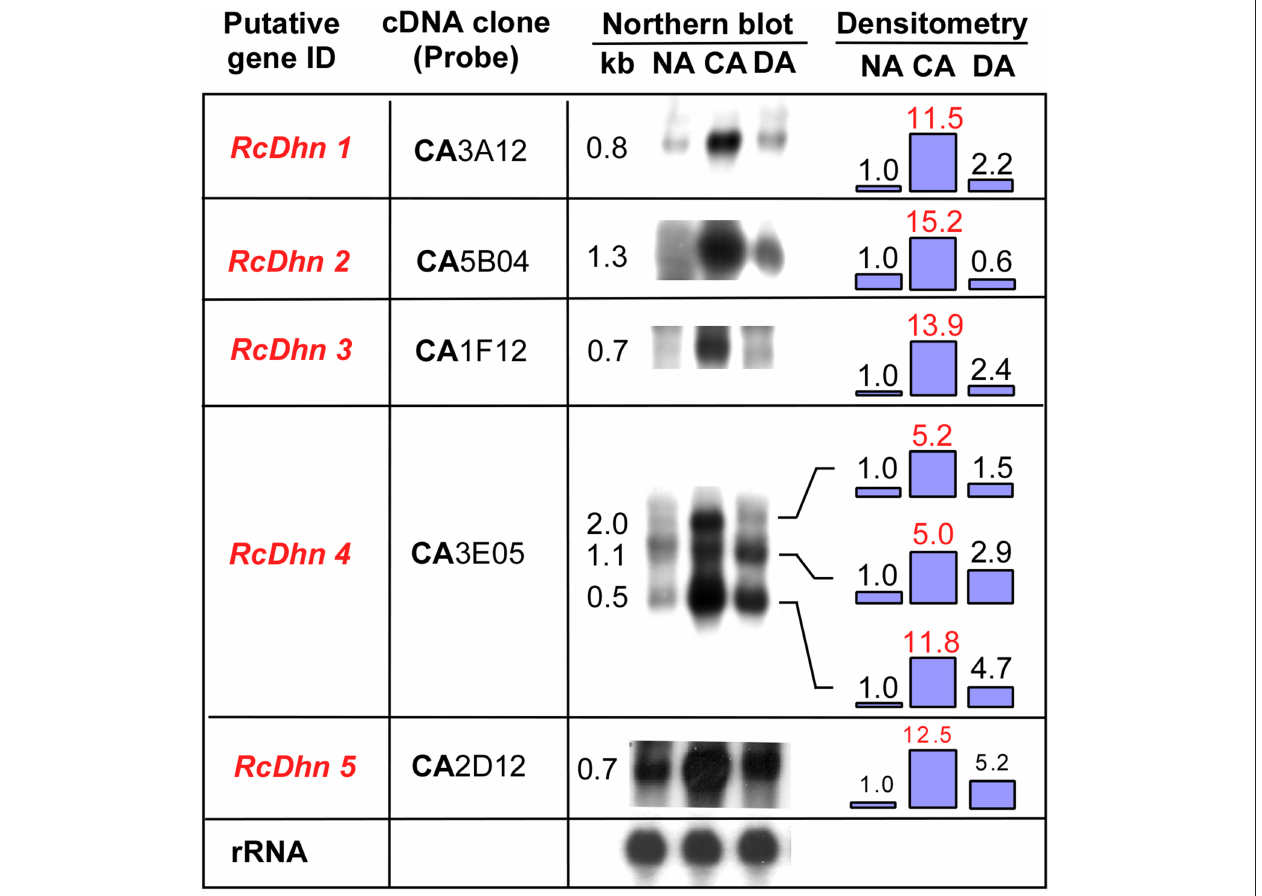
FIGURE 4 | Northern blot analysis for the seasonal expression levels of RcDhn 1-5 in NA, CA, and DA leaf tissues. Total RNA (8 µ g) was isolated and hybridized with respective cDNA probes. Lower panel shows control hybridization of the filters to rRNA using a blueberry cDNA probe confirming equal loadings among the lanes. Fold change in the expression level during cold acclimation and deacclimation relative to non-acclimated state (defined as ‘1’) was estimated by densitometry. The putative genes in red text showed at least 5-fold differences in the intensity of bands of northern blot between NA and CA, thus defined as highly cold-responsive genes. RcDhn 5 ’s northern blot data were adapted from a previous study (Peng et al., 2008). CA, cold-acclimated; DA, de-acclimated; NA,